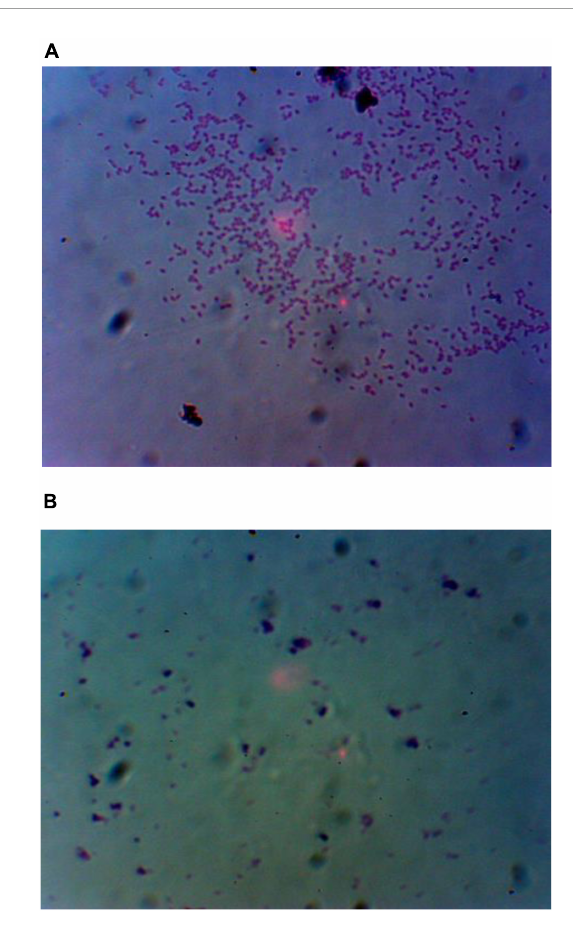
FIGURE4 (A) Alcian blue staining for detection of EPS in FSK3 ( Chromohalobacter sp.) without Mn treatment and (B) with 1 mM Mn treatment.